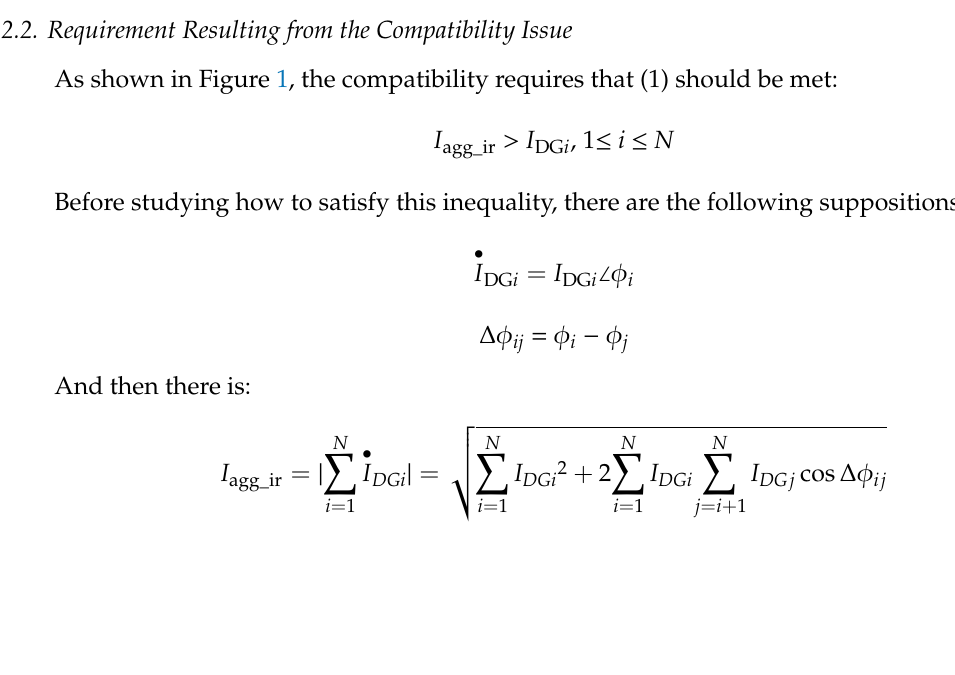
Figure 1. Irregular currents and voltage in multi-DG